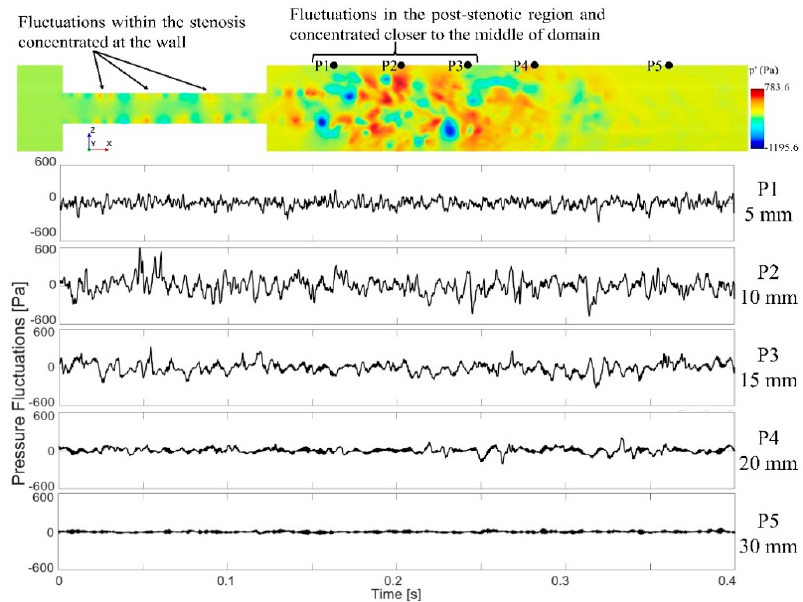
Figure 7. A cross-sectional view of the pressure fluctuations and time series data of the wall pressure fluctuations on the sample points at different locations downstream of the stenosis. Note that only a part of the flow domain close to the stenosis is shown in this figure. To localize sound sources, it is essential to find the point of maximum excitation in the post-stenotic region. Variation of the RMS of the pressure fluctuations along the wall and TKE along the centerline of the stenosis are shown in Figure 8. With the existence of flow recirculation, the RMS of pressure fluctuations started around 30 Pa at the exit of stenosis on the wall and increased to a maximum value of about 130 Pa at 11.5 mm down- stream of the stenosis (or about x = 2D), as shown with the red dot, Figure 8a. This is within the region of interest with the maximum arterial wall fluctuations. Similar results were concluded in a previous experimental study [24]. After the peak value, as the energy of fluctuations dissipated, the RMS of the pressure fluctuations was down to around 20 Pa at about x = 40 mm, and it gradually decreased to zero along the wall. Similarly, in Figure 8b, TKE increased from the exit of the stenosis on the centerline and reached the highest level at about the same point shown with the red dot. TKE re- duced rapidly as the flow became reattached and laminarized. From x = 30 mm to the exit, the turbulent flow became stable and fully developed further downstream of the stenosis, as shown in Figures 3 and 4.